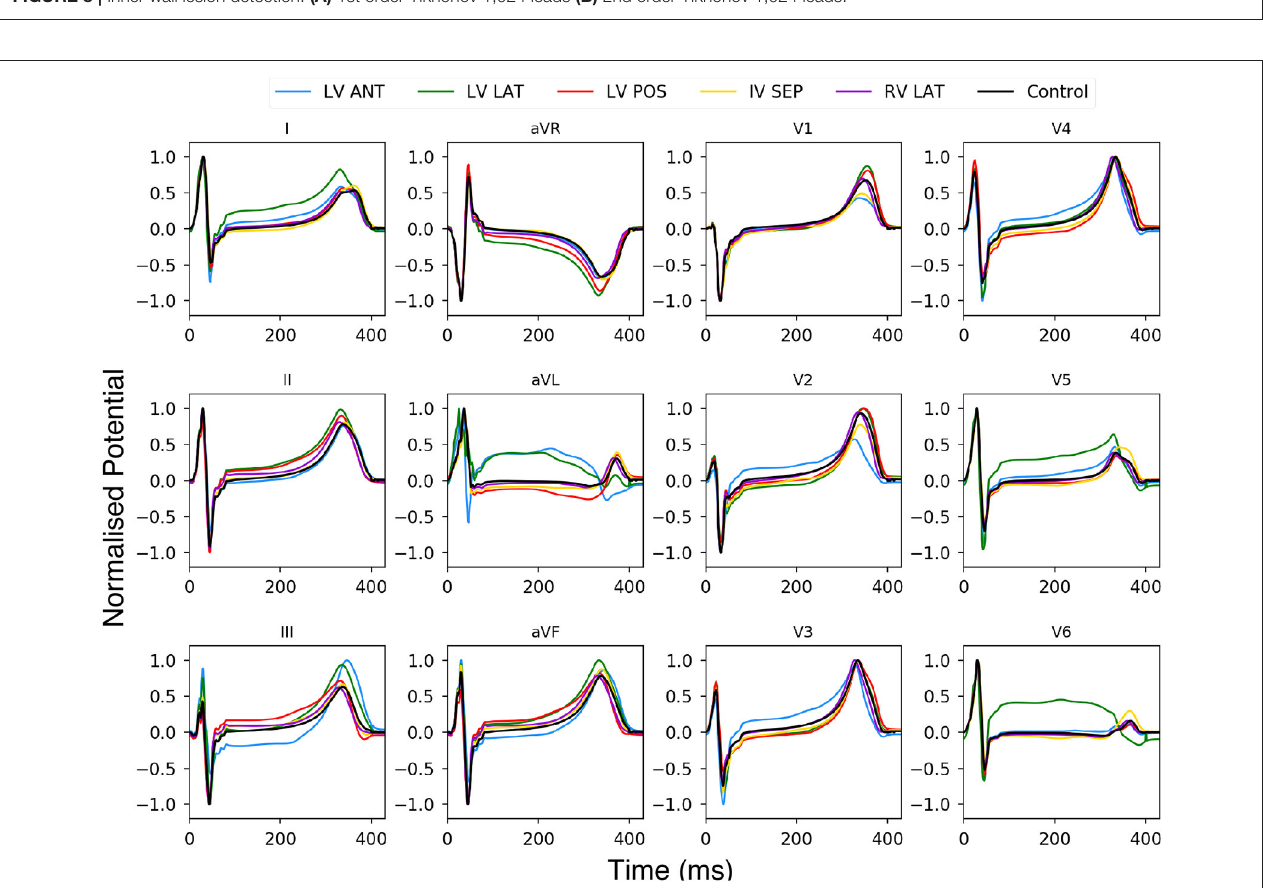
the 14 mm lesion was detected but along with a substantial area of incorrect regions that should have been detected as healthy areas of the ventricle as seen in Figure 12C . Therefore, this